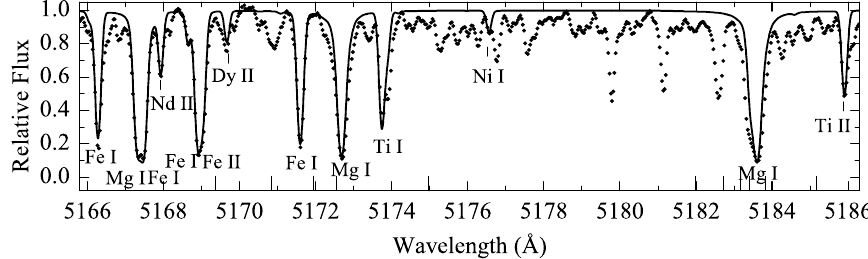
Fig. 13. The observed spectrum of HD 209621 around the magnesium triplet. Important atomic lines are identified, and the synthetic spectrum is given for the final abundances of iron peak elements and the magnesium abundance log ϵ (Mg) = 5 . 77.